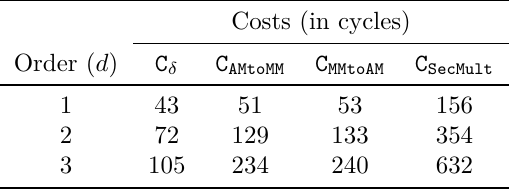
Table 3: Costs of Secure - Dirac (Alg. 3), AMtoMM (Alg. 4), MMtoAM (Alg. 5) and SecMult (Alg. 1).